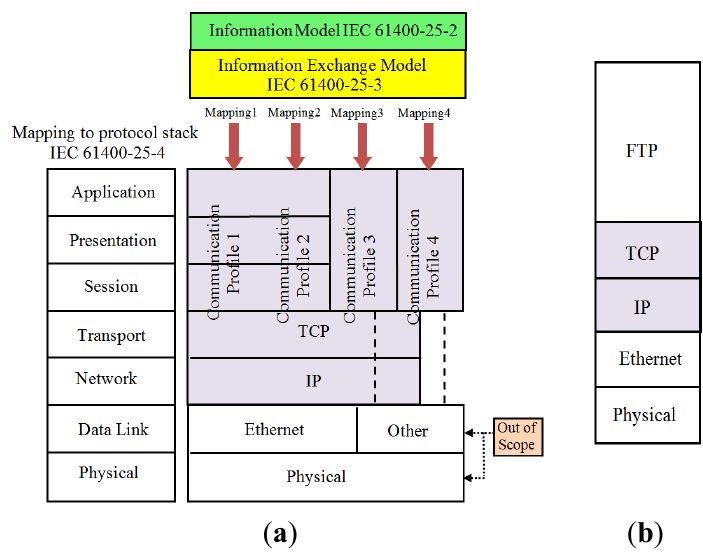
Figure 6. ( a ) Different mapping configuration based on IEC 61400-25-4; ( b ) Communication protocol stack of FTP.